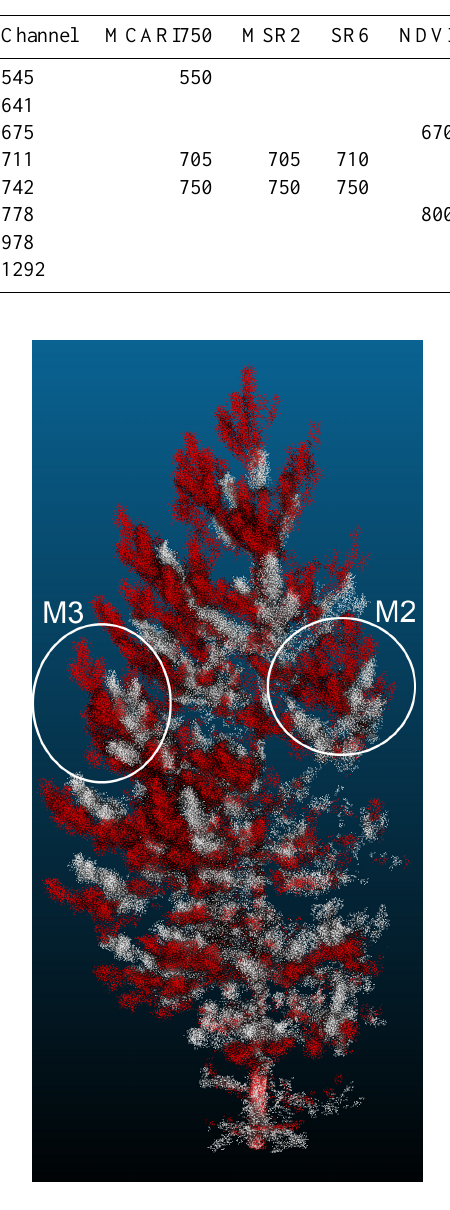
Figure 1. Co-registered point clouds from the 15 May 2013 scan (grey) and the 11 June 2013 scan (red). Growth of the tree is visi- ble and also some movement of the branches can be observed. The height of the tree is approximately